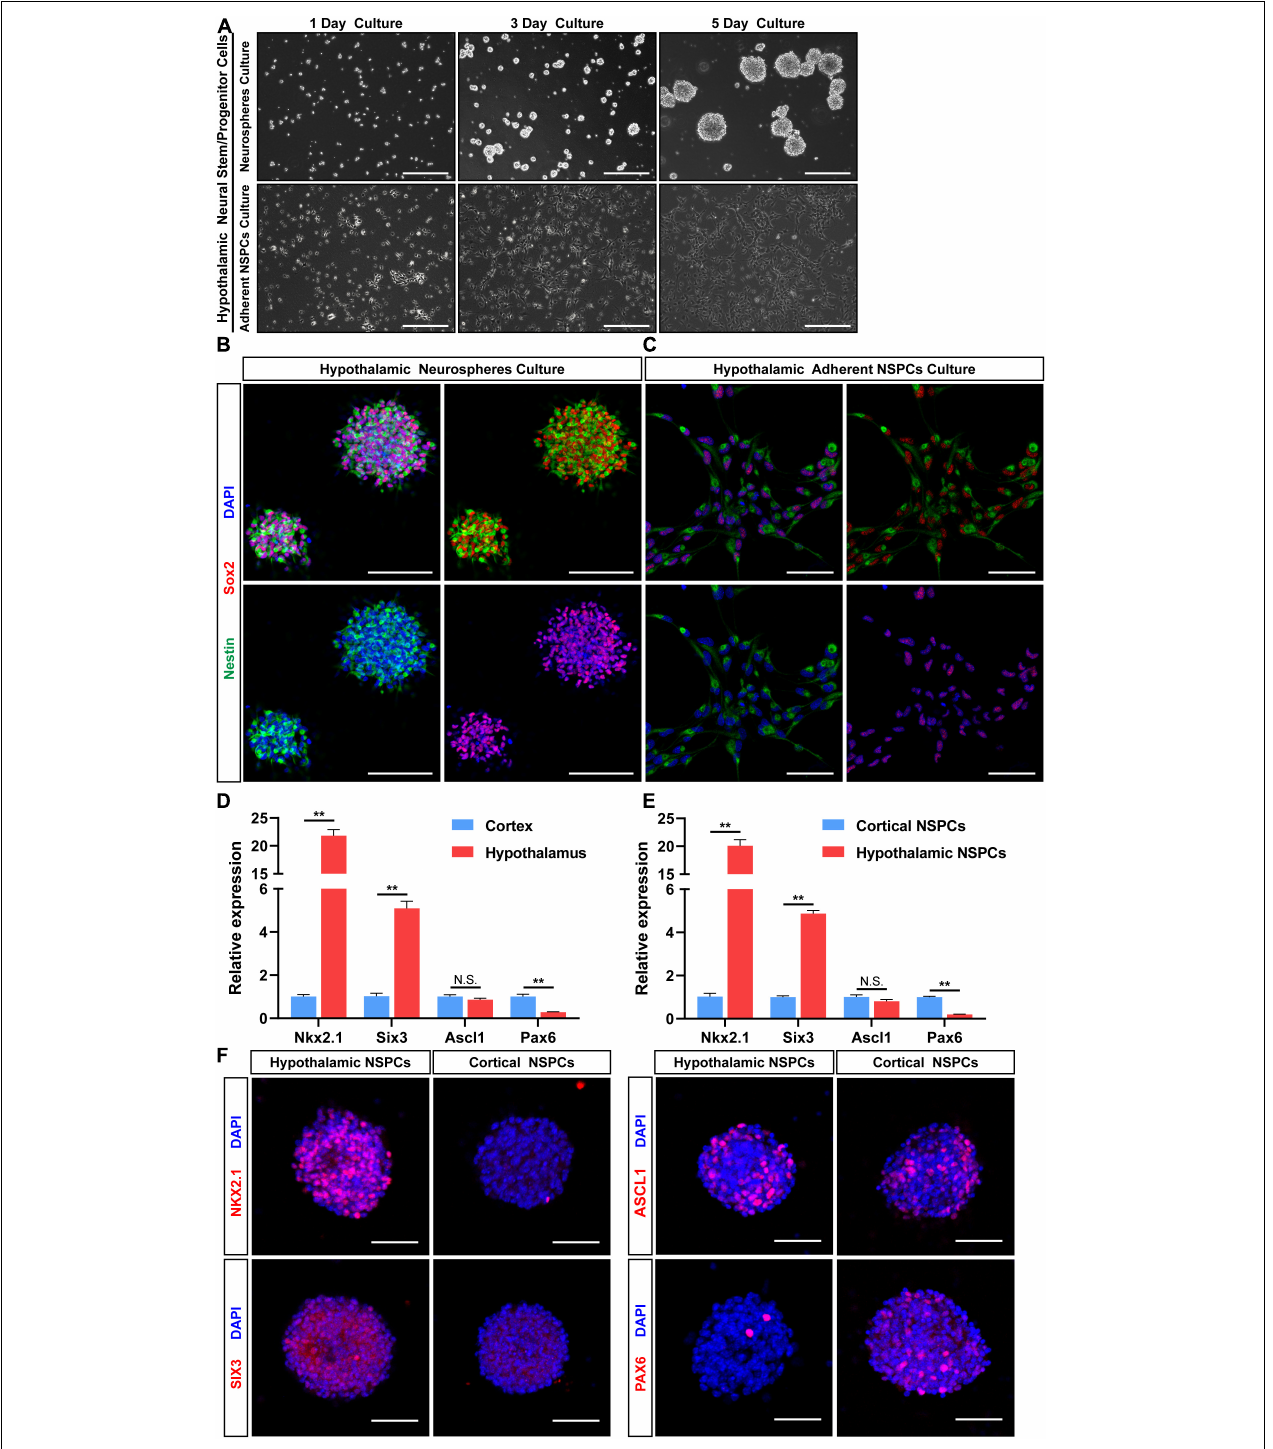
FIGURE 3 | Maintenance of hypothalamic NSPCs as neurospheres and adherent NSPC cultures. (A) Images of hypothalamic primary NSPCs cultured as neurospheres and monolayer cells for 1, 3, and 5 days. Scale bar: 200 µ m. (B,C) Double immunostaining for Sox2 (red) and Nestin (green) of hypothalamic primary NSPCs in two culture methods. Scale bar (B) 100 µ m, scale bar (C) 50 µ m. (D) qRT-PCR analysis of the E12.5 hypothalamic and cortical tissue expression levels of Nkx2.1, Six3, Ascl1, and Pax6. (E) qRT-PCR analysis of the cultured hypothalamic and cortical NSPCs (passage 3–5) expression levels of Nkx2.1, Six3, Ascl1, and Pax6 ( n = 3 in each group). Data are showed as mean ± SEM. ** P < 0.01 by two-tailed Student’s t -test. (F) Immunostaining for NKX2.1, SIX3, ASCL1, and PAX6 of hypothalamic and cortical neurospheres (passage 3–6). Scale bar: 50 µ m.